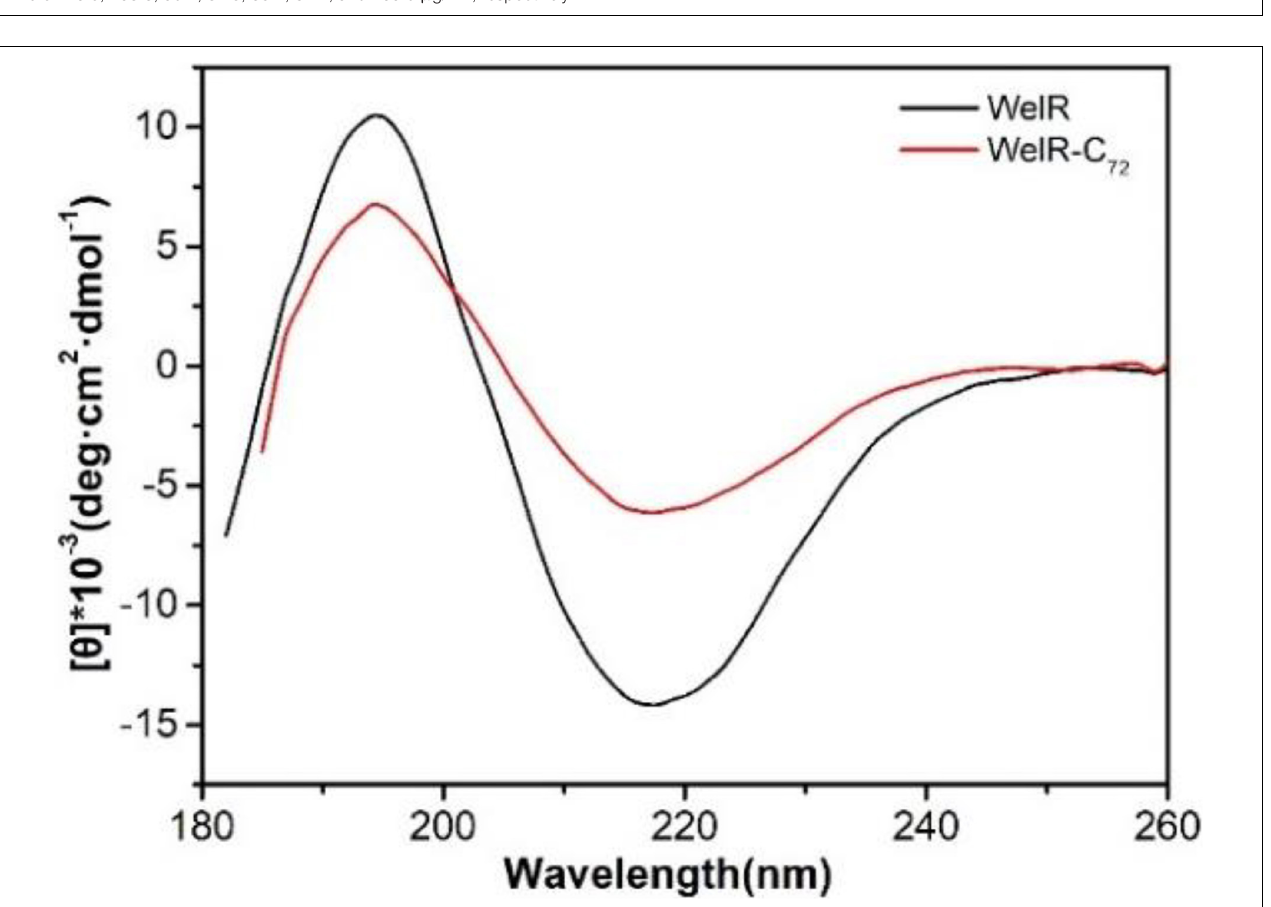
FIGURE 3 | CD spectra of WelR and WelR-C 72 . The concentrations of WelR and WelR-C 72 were about 120 and 100 µ g/mL, respectively.